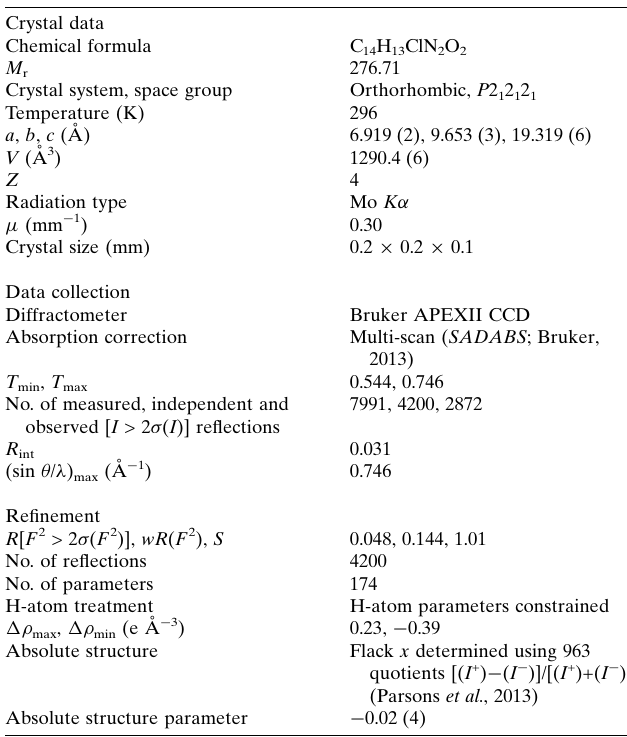
Table 1 Hydrogen-bond geometry (A˚ , (cid:2) ).